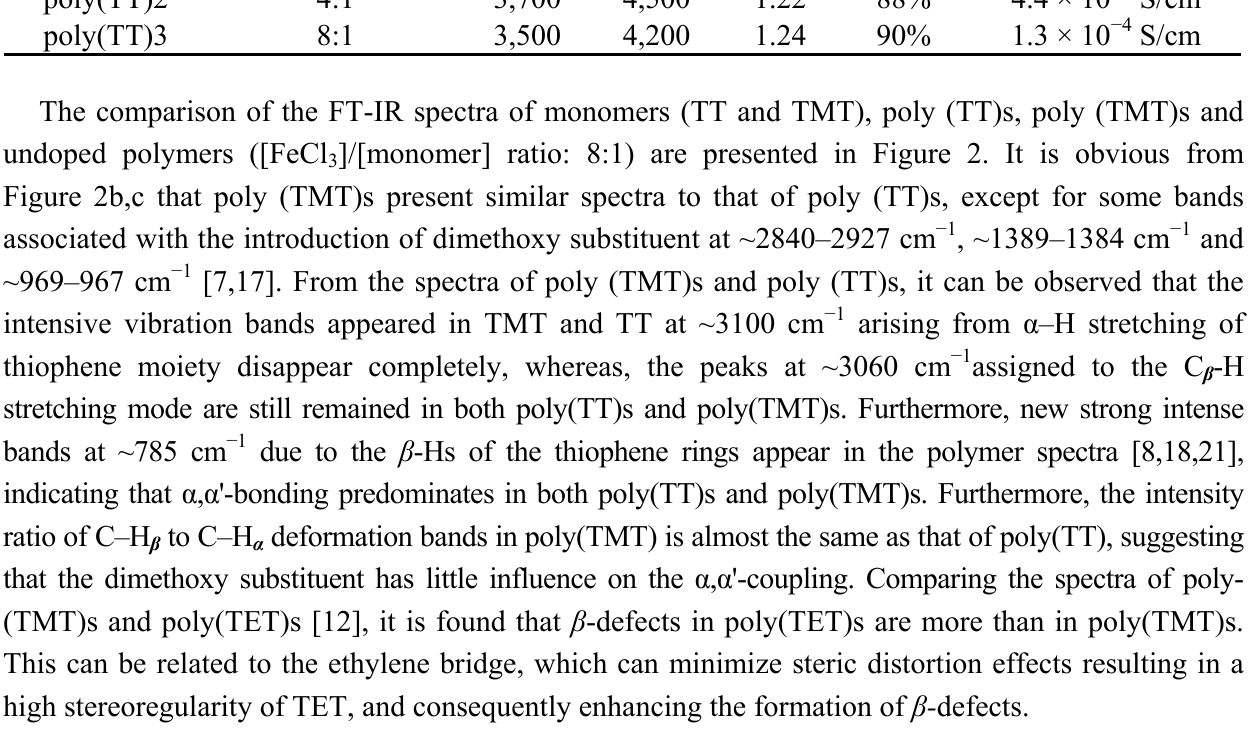
Figure 2. FT-IR spectra of monomers and polymers: ( a ) monomers (TMT and TT); ]/[monomer] ratio: 2:1; 4:1; 8:1; ( d ) ( b ) poly (TT)s; ( c ) poly (TMT)s; [FeCl 3